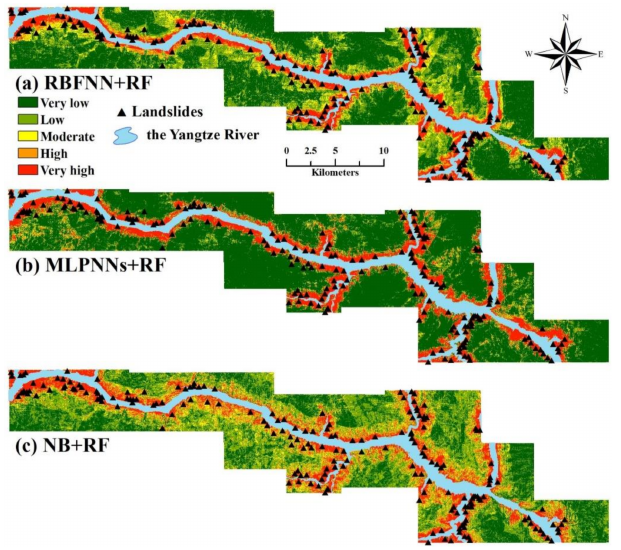
Figure 6. Landslide susceptibility maps for different state-of-the-art ensemble methods. ( a ) RBFNN+RF, ( b ) MLPNNs+RF, and ( c )